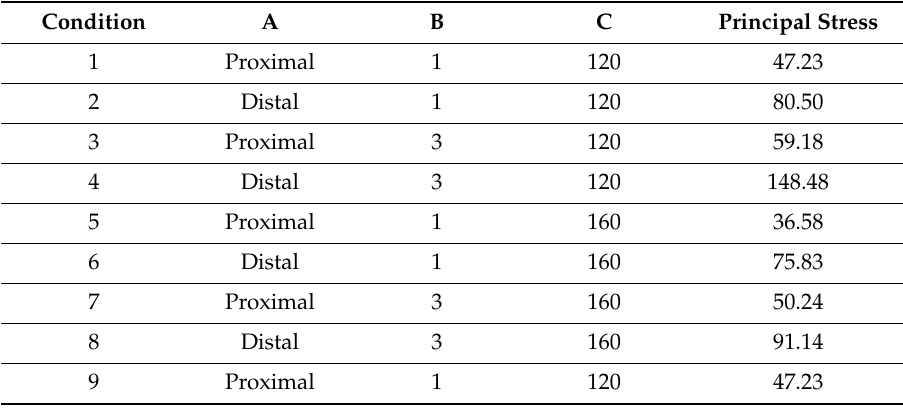
Table 11. FEA model of the six locking screws’ results for the testing